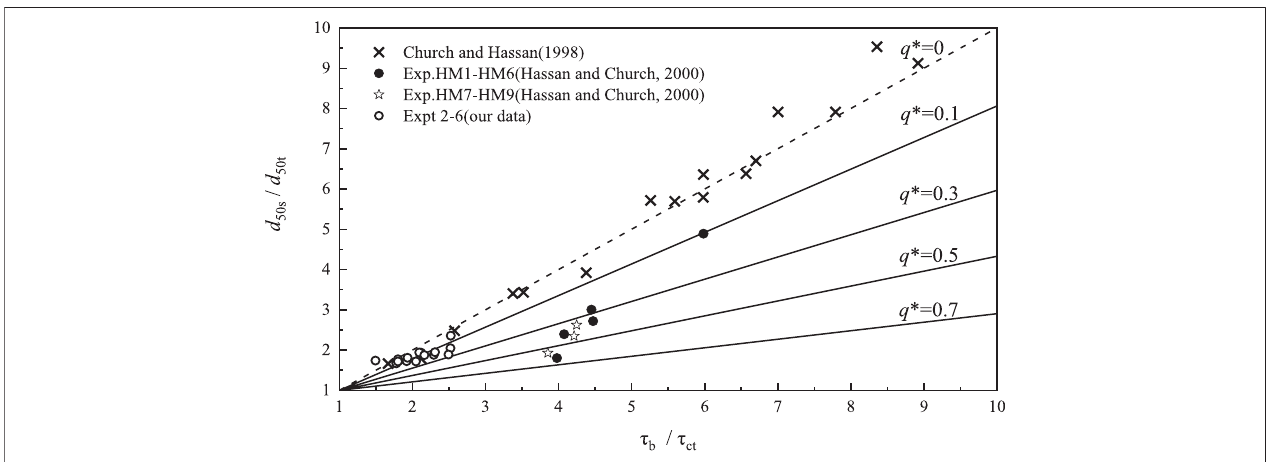
p . The solid circles represent the data ofExp. HM1-HM6 Hassan and / D τ / τ 50 50 s and b ct for various q